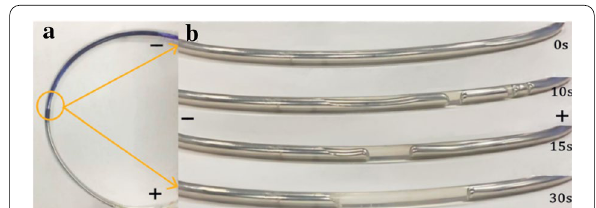
Figure 2 a Compression of LM occurred at one end of the cathode, b The time-lapse images of formation and expansion of the fracture layer of LM